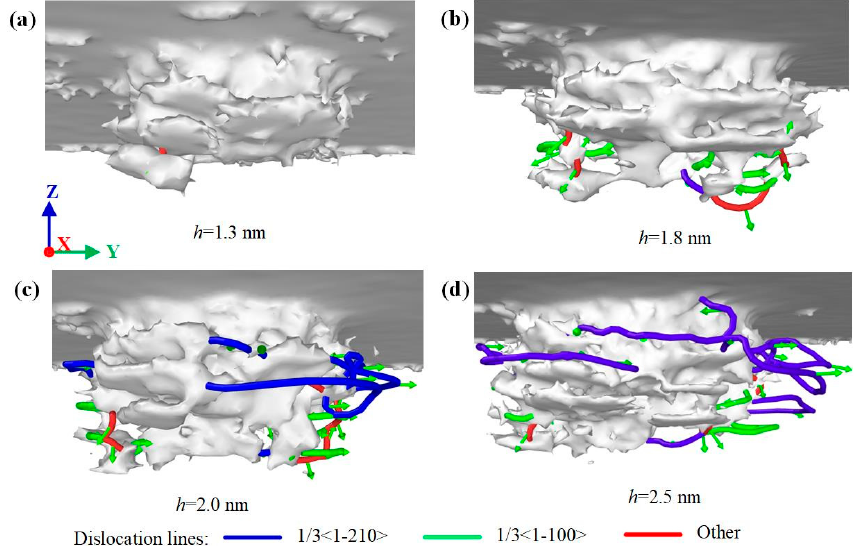
Figure 9. Dislocation distribution of 4H-SiC at different indentation depths: ( a ) h = 1.3 nm, ( b ) h = 1.8 nm, ( c ) h = 2.0 nm, and ( d ) h = 2.5 nm, respectively.